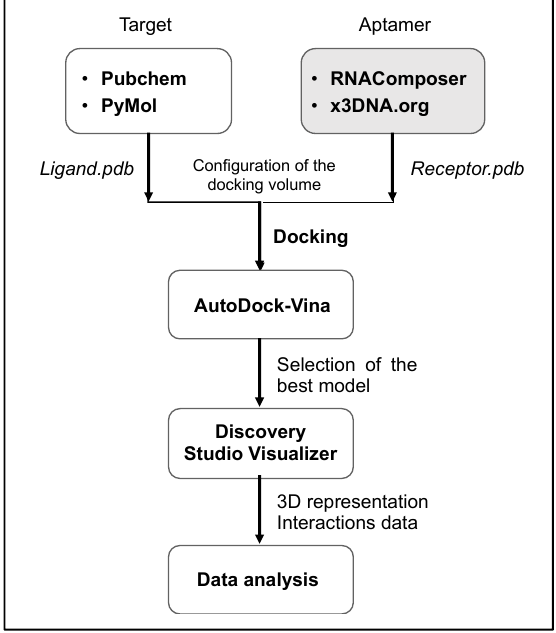
Figure 2. Molecular docking procedure as followed in the current work.